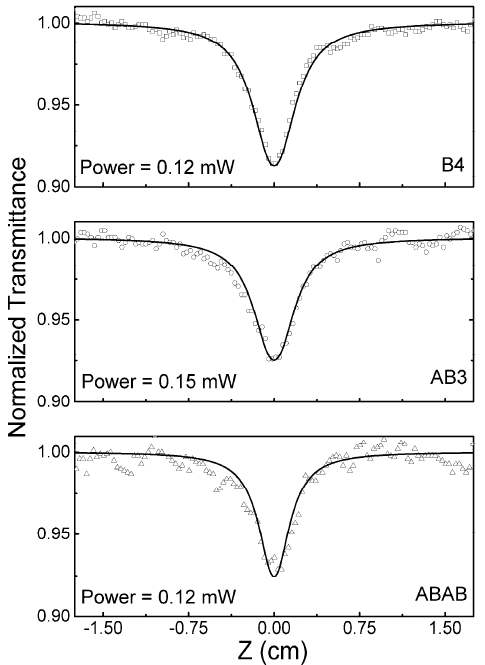
Figure 4. Normalized transmittance obtained by the single pulse Z-scan at 532 nm (symbols). The solid line represents the theoretical fitting obtained by using the rate equations (Equation (2)) and Equation (1).